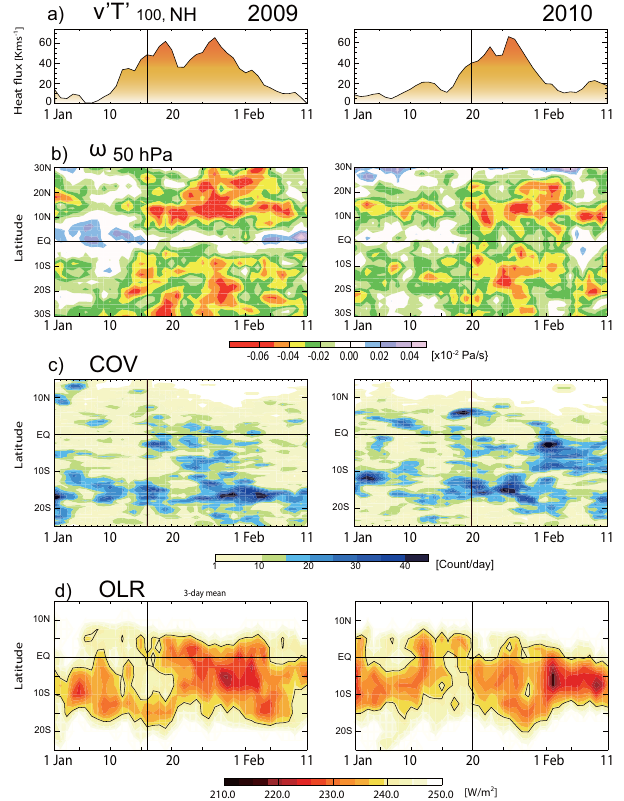
Figure 1. (a) Time series of the eddy heat flux at 100hPa aver- aged over 45–75 ◦ N (Kms − 1 ). (b) Zonal mean pressure coordinate vertical velocity at 50hPa (Pas − 1 ). (c) Number of convective over- shootings per day at each latitude. (d) Zonal mean OLR (Wm − 2 ). Variables are displayed from 1 January to 11 February. Left- and right-hand panels are for 2009 and 2010, respectively. Vertical ve- locity and OLR data are smoothed by a 3-day running mean.